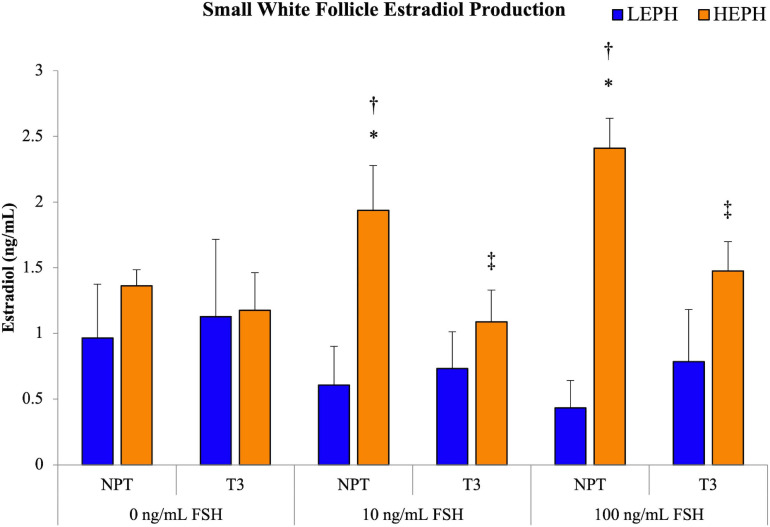
Impact of thyroid hormone on estradiol production. Estradiol production in small white follicle cells from low egg producing hens (LEPH) and high egg producing hens (HEPH) after pretreatment with no pretreatment (NPT) or thyroid hormone (T3) followed by treatment with follicle stimulating hormone (FSH). Significant expression differences between LEPH and HEPH for a given condition are denoted with an asterisk (*) (P < 0.05). Significant differences between FSH treatments for a given egg production group are denoted with a dagger (†) (P < 0.05). Significant differences between pretreatments for a given egg production group are denoted with a double dagger (‡) (P < 0.05).